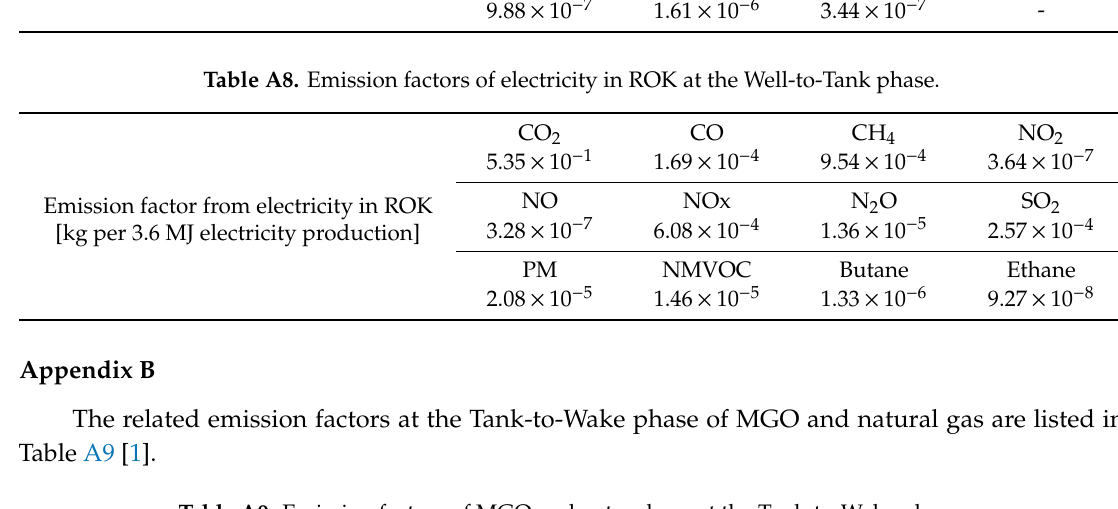
Emission factor from renewable energy